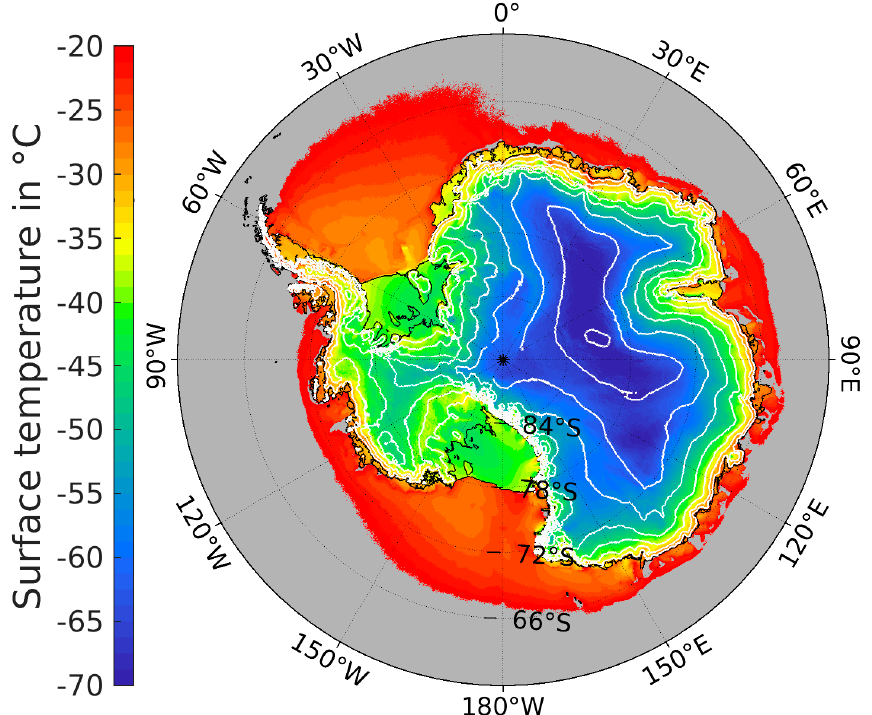
Figure 5. Mean cloud-free surface temperature for winter (April–September) 2002 to 2017 (isolines = topography every 500 m, temperatures outside the range in grey).